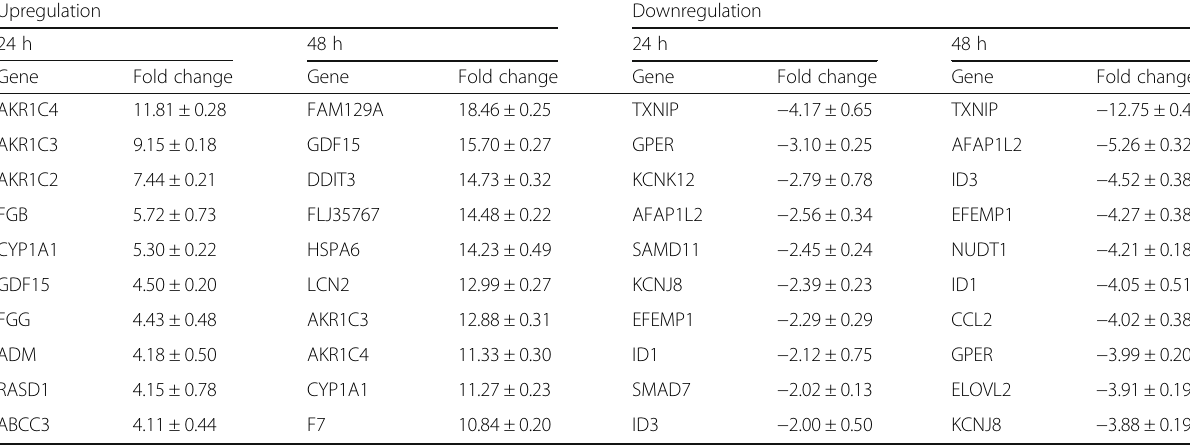
Each value represents mean±SD ( n =3)